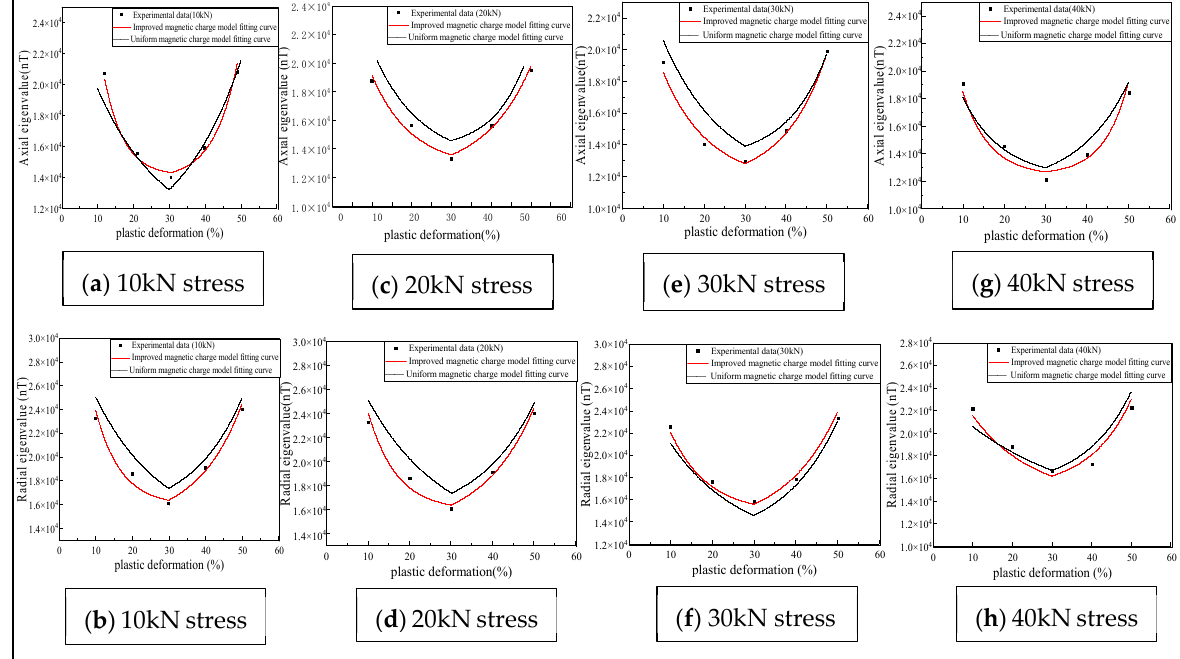
Figure 19. Relationship between plastic deformation and eigenvalue under different stresses. Table 2. Precision analysis of the improved magnetic charge model and uniform magnetic charge model.